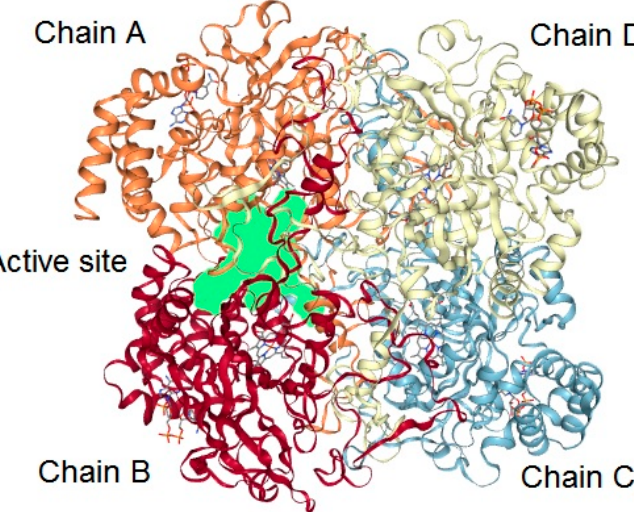
Figure 6. The structure and active site of S. schenckii catalase. The active site is surrounded by β -barrels, α -helices and loops. The active site of SsCAT1 is shown in light green.